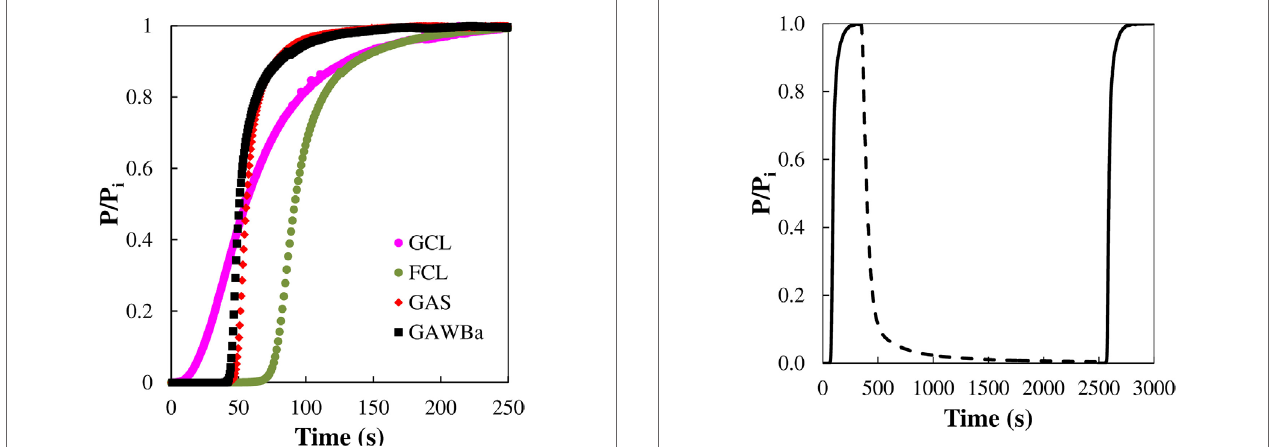
FigUre 8 | cO 2 breakthrough curves at 25°c and 101.3 kPa (0.4 g of adsorbent, 50 cm 3 sTP/min, 15% cO 2 in n 2 ) over the samples gas, gaWBa, gcl, and Fcl .